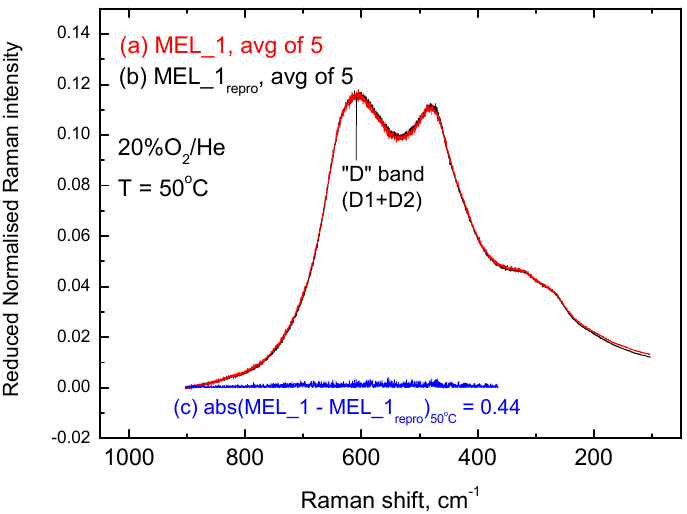
Figure 2. Reduced and normalized in situ Raman spectra obtained for two specimens of the same lot of the MEL_1 material under 20% O 2 / He at 50 ◦ C after 2 h treatment at 450 ◦ C. (a) Average of five sequential recordings for MEL_1; (b) average of five sequential recordings for MEL_1repro; (c) absolute di ff erence of traces (a) and (b). The 0.44 value corresponds to the integral under trace (c). Recording parameters, see Figure 1